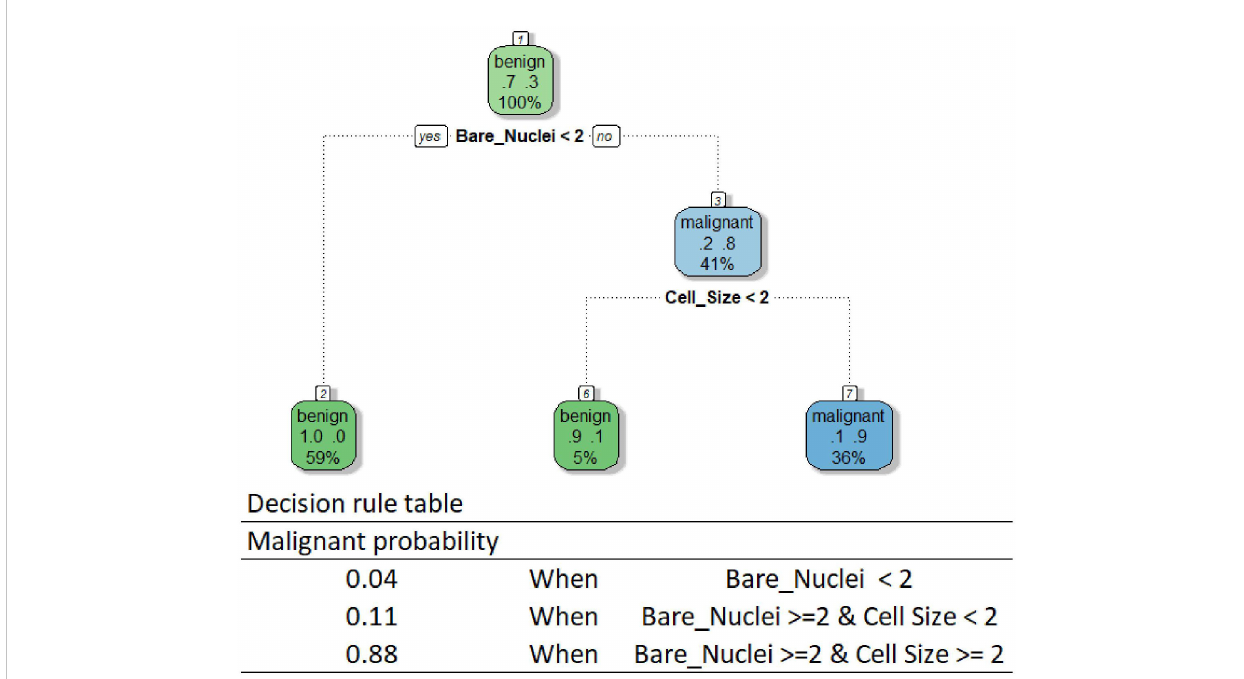
FIGURE 2 Decision tree (DT) and rule